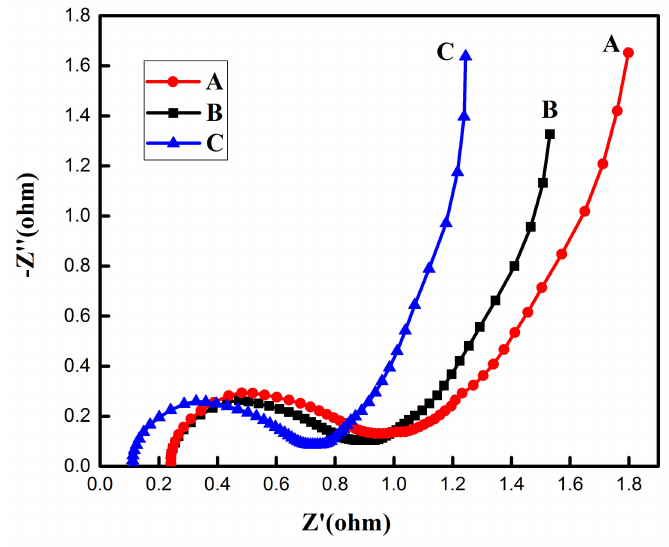
Figure 7. EIS of the di ff erent Co 3 O 4